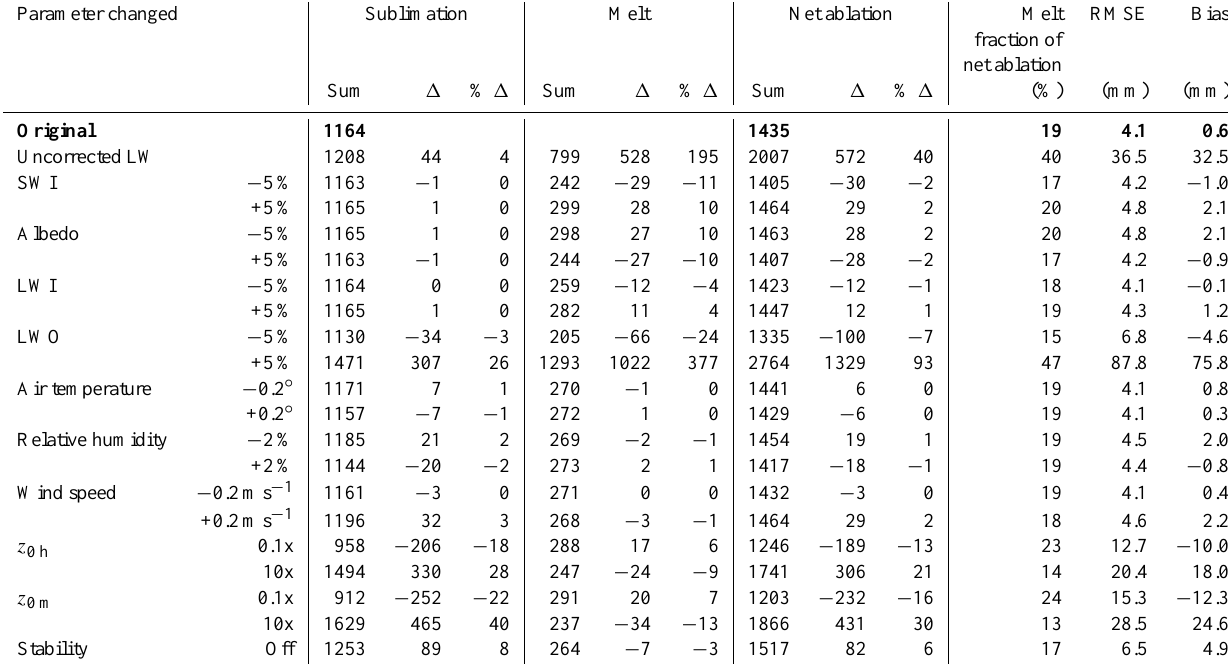
Table 4. Sensitivity analysis undertaken for several model variables. The uncorrected longwave radiation is tested; the other variations to